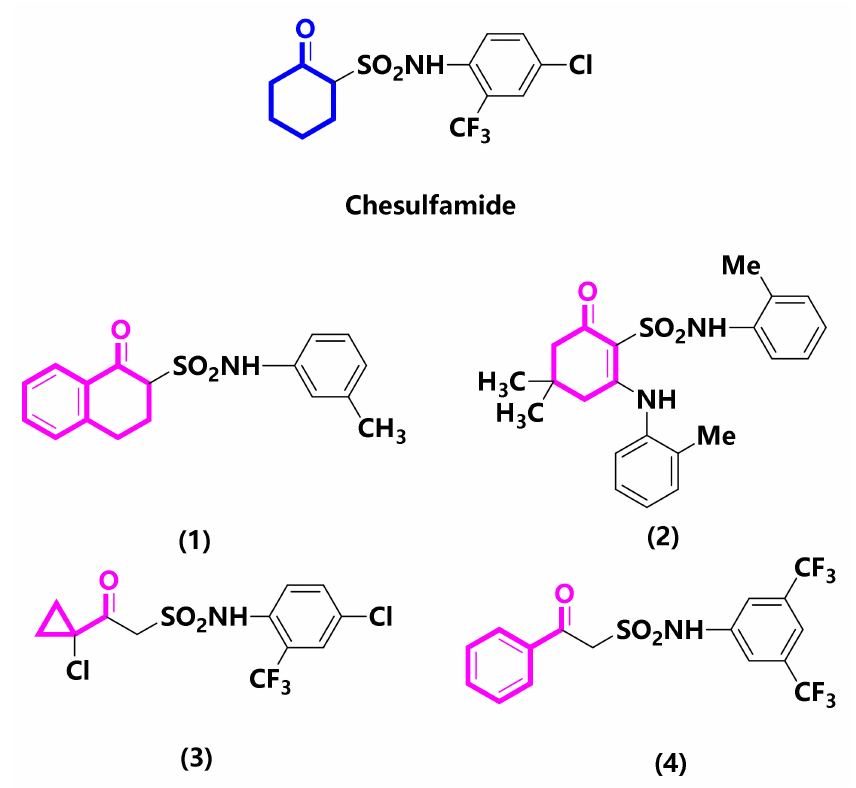
Figure 1. Structures of active compounds in previous work.